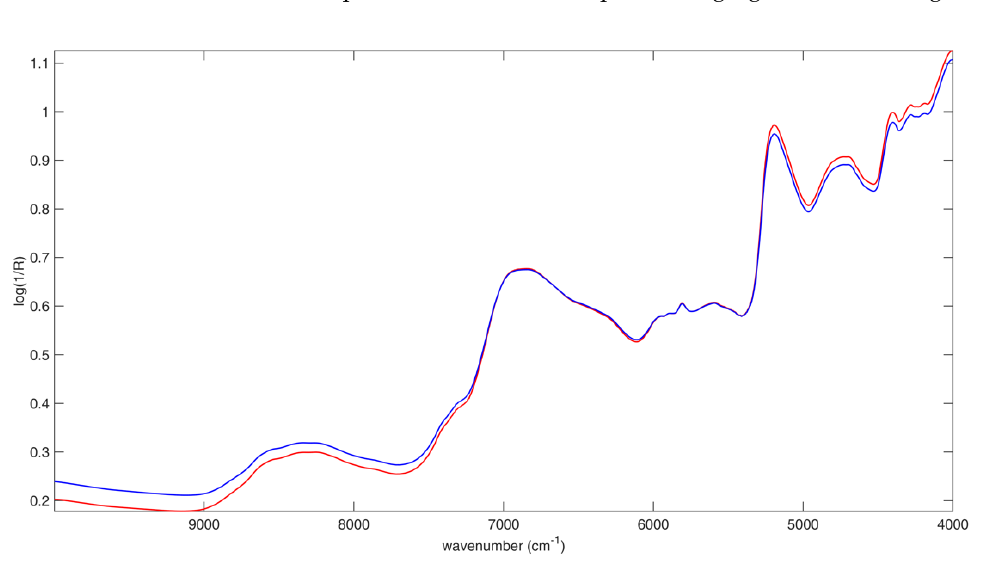
Figure 4. Average raw spectra collected on Sorrento (blue line) and Non-Sorrento (red line) walnuts (kernel).